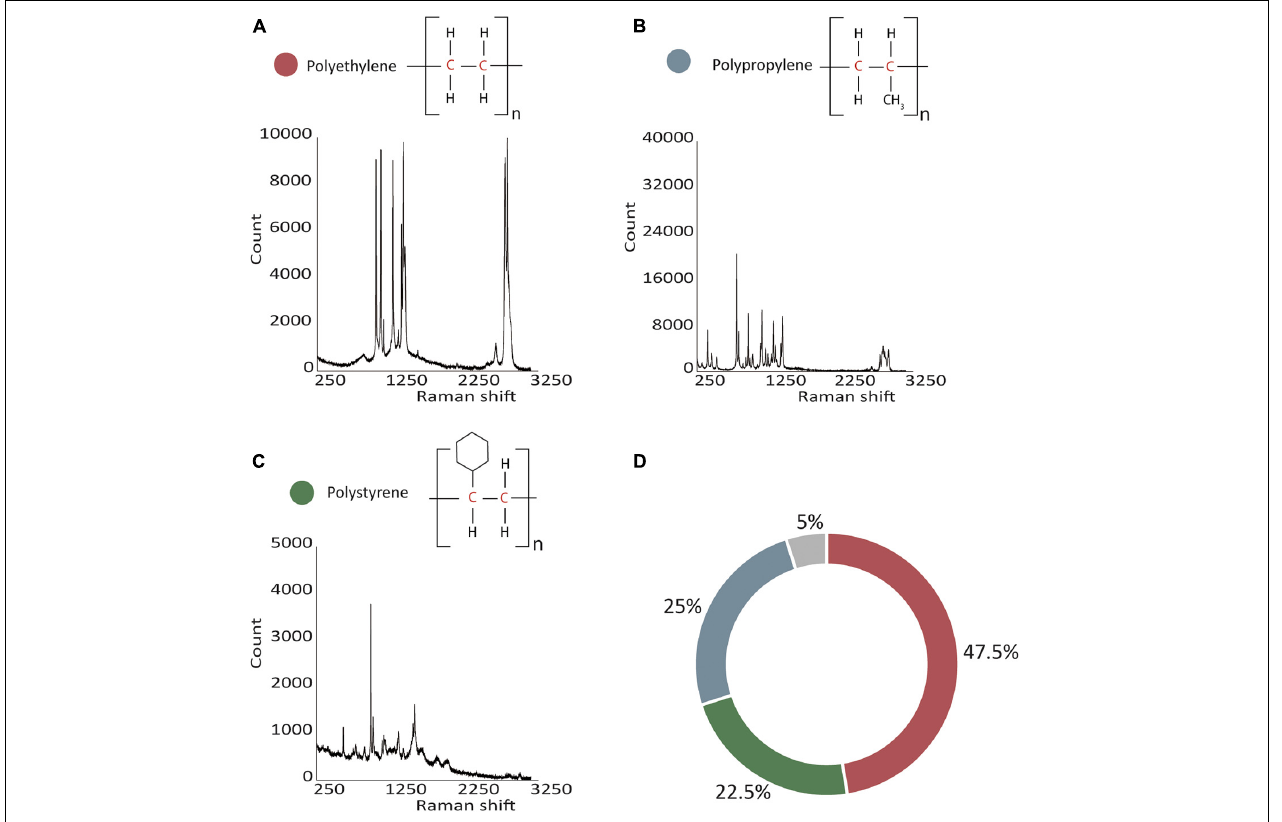
FIGURE 1 | Classification and distribution of 40 plastic particles. (A–C) Identification of polymers was achieved with Raman spectroscopy, representative Raman spectra are shown. (D) Most particles were identified as PE followed by PP and PS, and 5% of particles remained unidentified (polyethylene in red, polypropylene in blue, polystyrene in green, and unidentified particles in